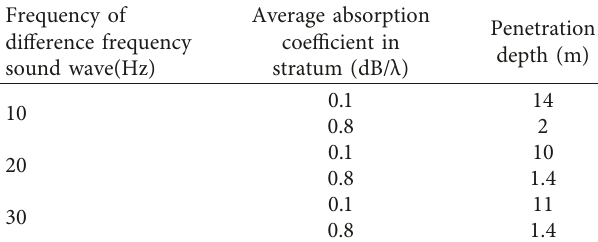
Figure 3: Source levels of the parametric array. The density of water is 1kg/m 3 , and the sound absorption coefficients at 300kHz, 40kHz, 30kHz, 20kHz, and 10kHz are 23.4dB/km, 0.416dB/km, 0.234dB/km, 0.104dB/km, and 0.026dB/km, respectively, at 15 ° C.